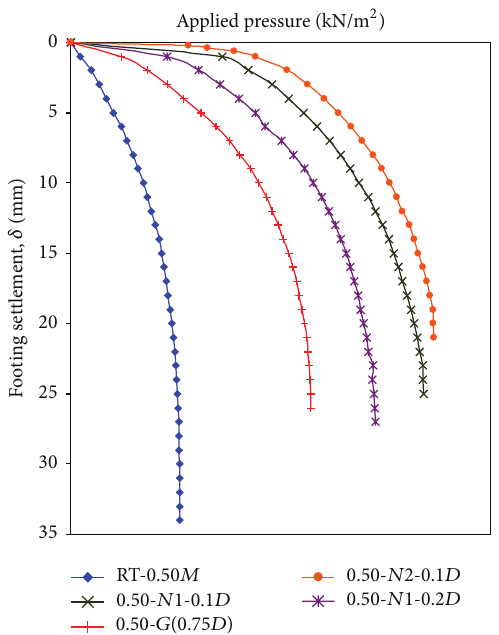
Figure 10: Load-settlement curve for Series II ( 𝐷 = 0.75 𝑀 ), comparison.